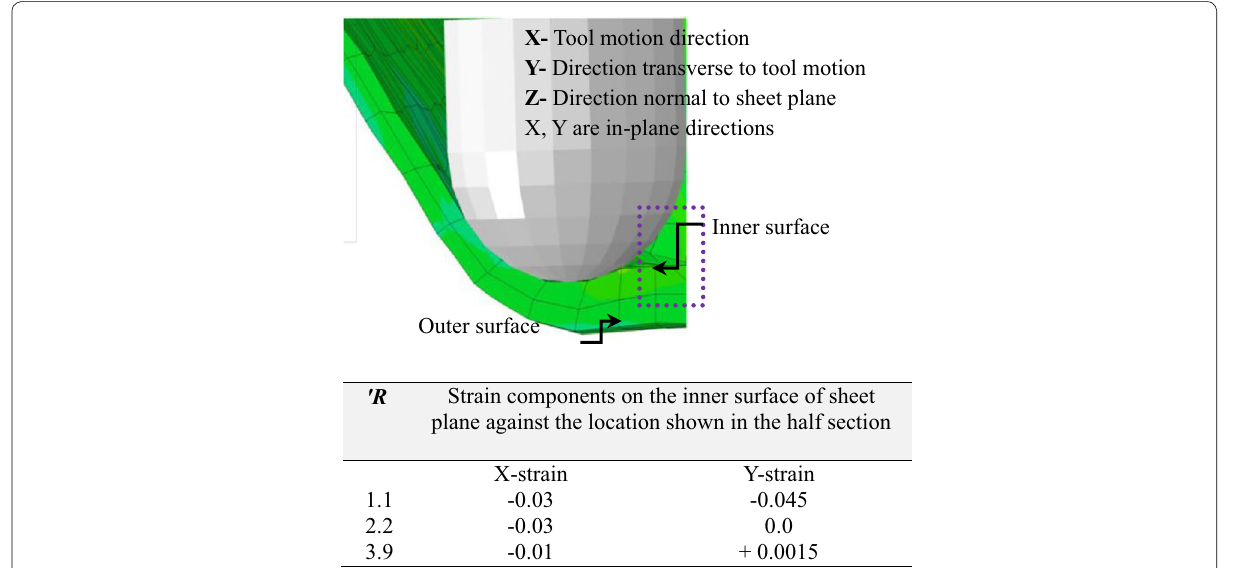
Figure 4 Strain state of sheet in front of